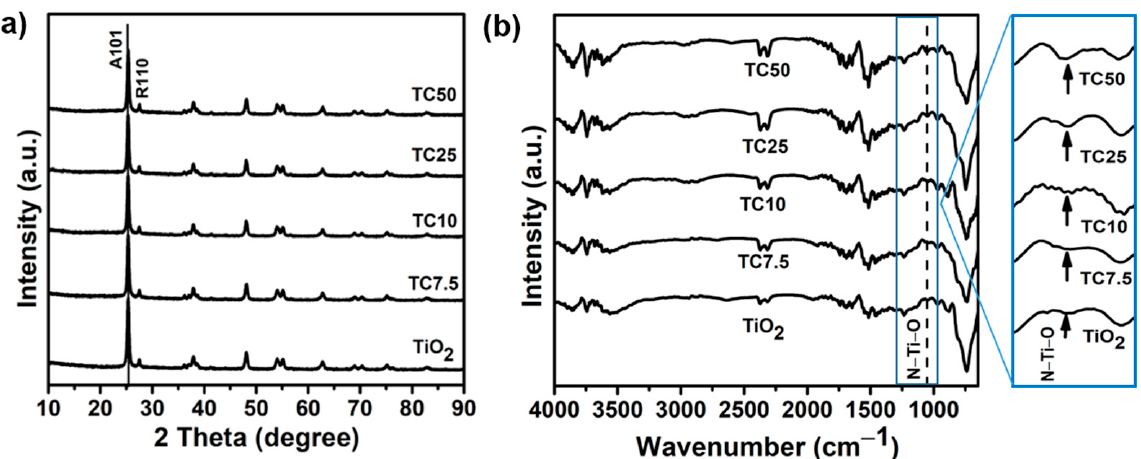
Figure 1. ( a ) XRD patterns and ( b ) FT-IR spectra of pure TiO 2 P25 and the synthesized N-doped TiO 2 materials (TCX; TC means N-doped TiO 2 , X is wt% of TCA on TiO 2 ).